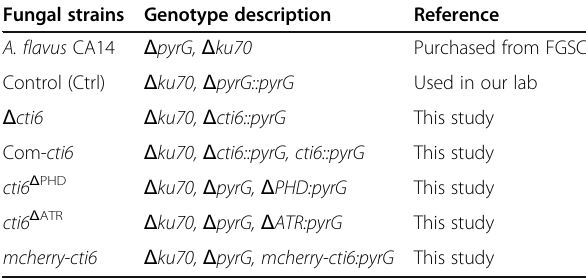
Table 1 A. flavus strains in the